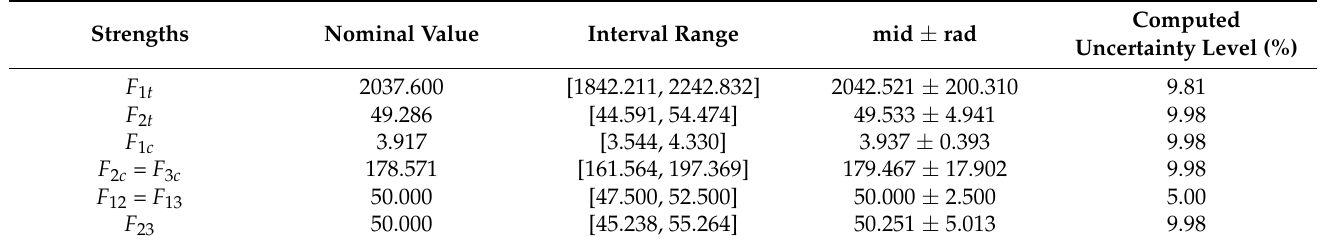
Table 8. Nominal values and computed uncertainty intervals of the AS4/3501/6 composite ply strengths.